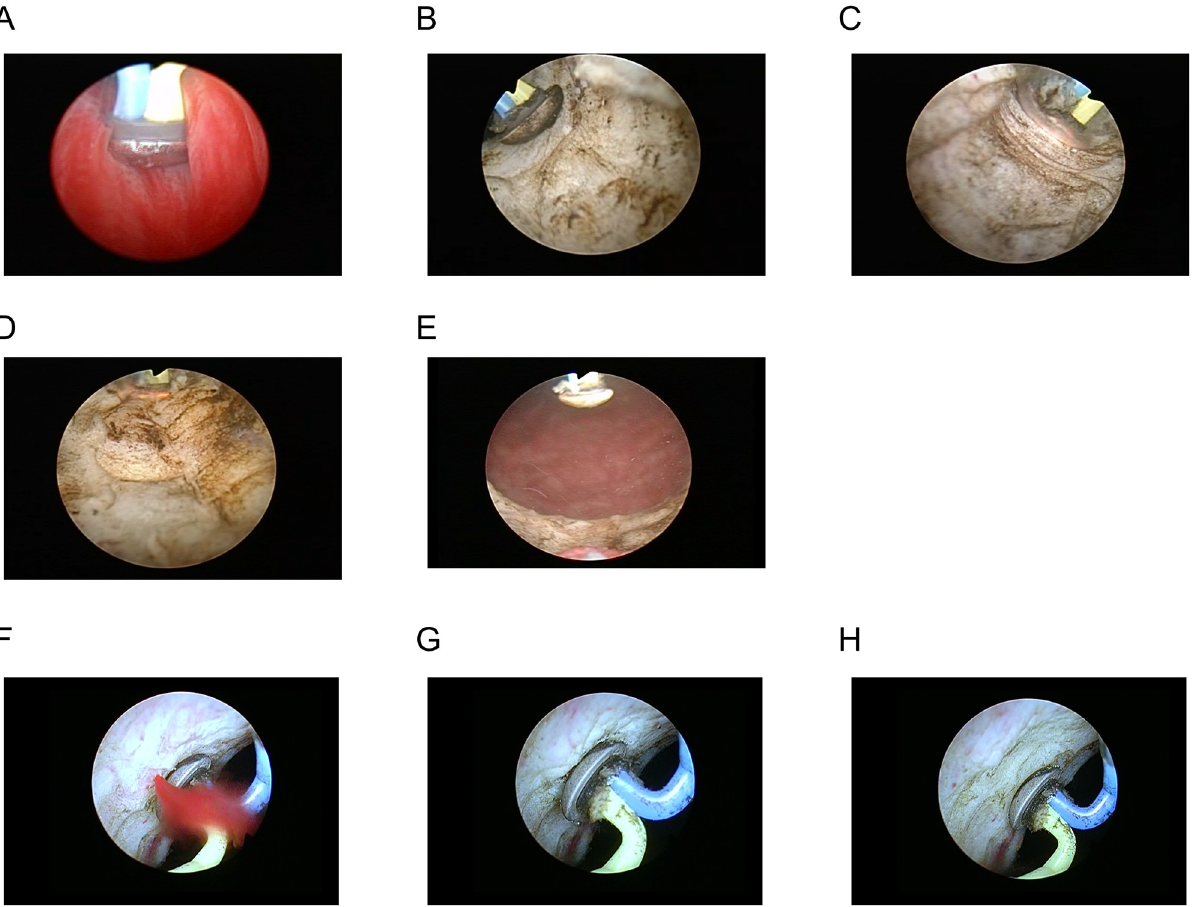
Fig 2. After careful observation of the enlarged prostate (A), the vaporization procedure started with the creation of a working space at 5 (B) and 7 o’clock (C). Following vaporization of the middle (D), and lateral lobes, well-opened prostate and bladder neck were confirmed (E). The coagulation setting could rapidly be deployed with the same electrode, and even arterial bleeding (F) could be terminated immediately (G, coagulation with oval- shaped electrode, H, confirmation of cessation of bleeding).